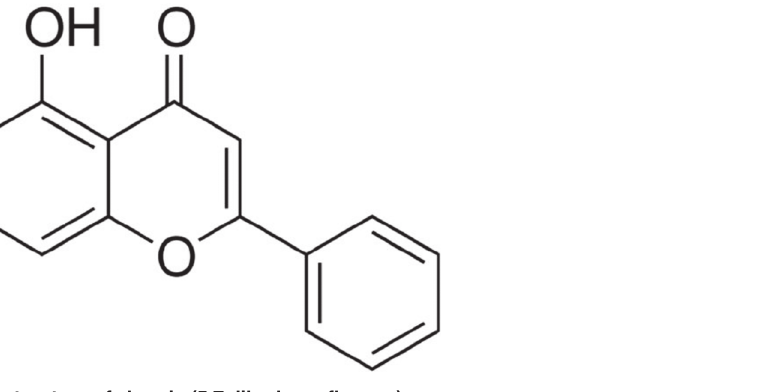
Fig 1. Chemical structure of chrysin (5,7 dihydroxy